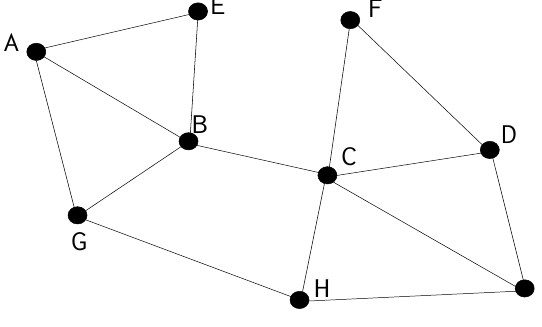
Figure 2. The topological map.